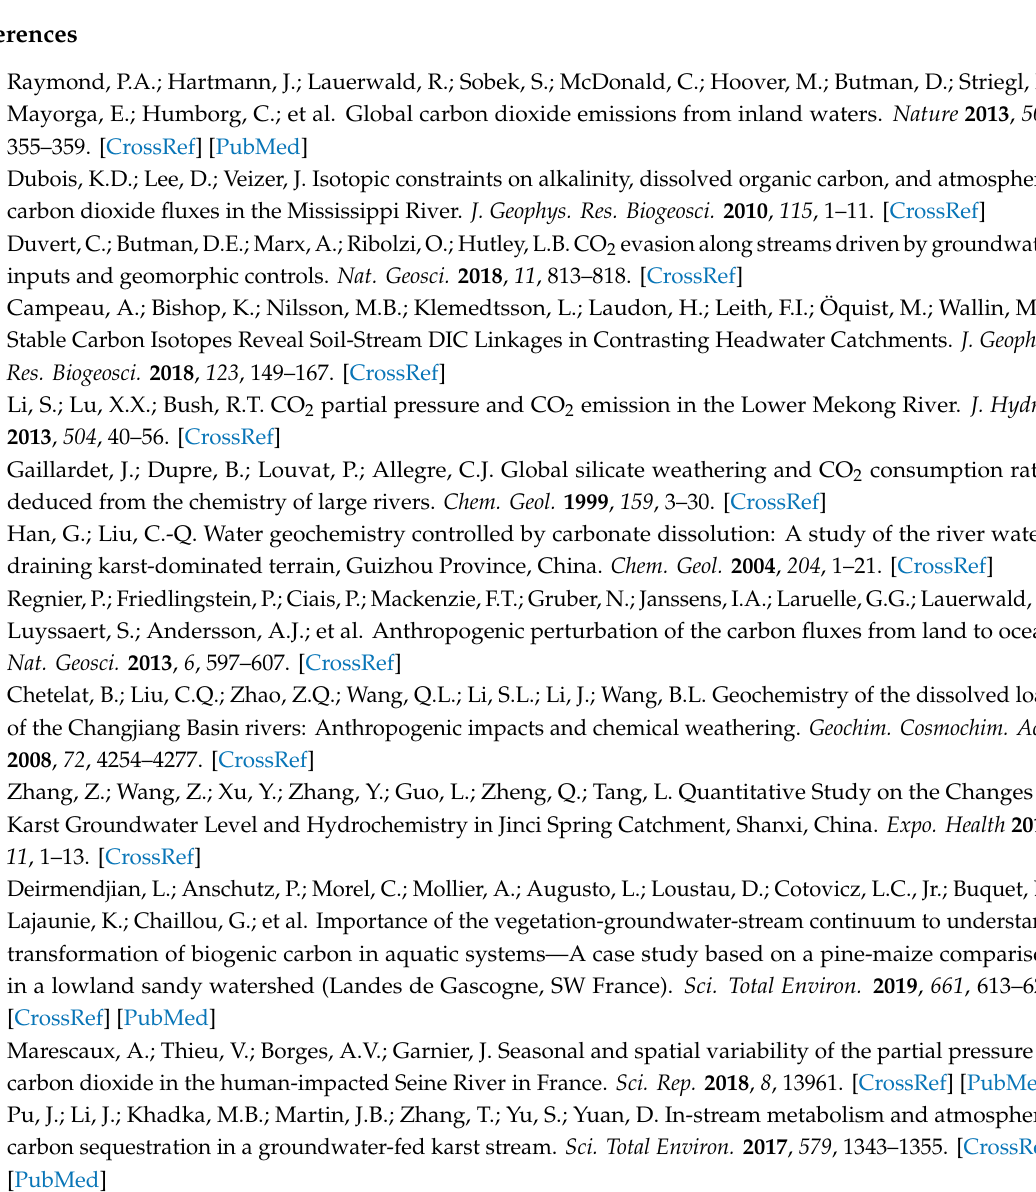
Table S1: The physical–chemical parameters and major ions concentration in the Mun River, Table S2: DIC system and carbon isotope composition of surface water and